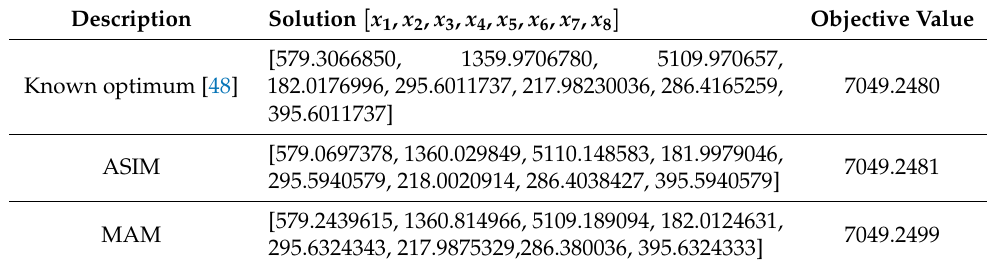
Table 9. Optimal solutions of G10 found by ASIM and MAM.